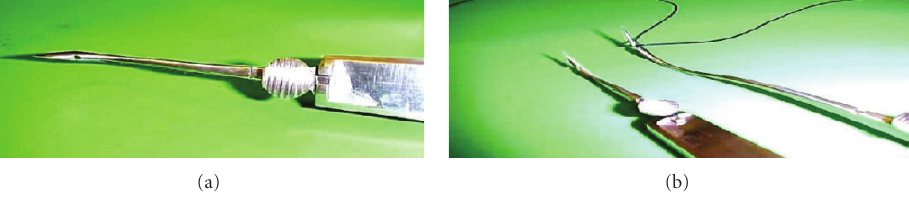
Figure 1: Reverdin